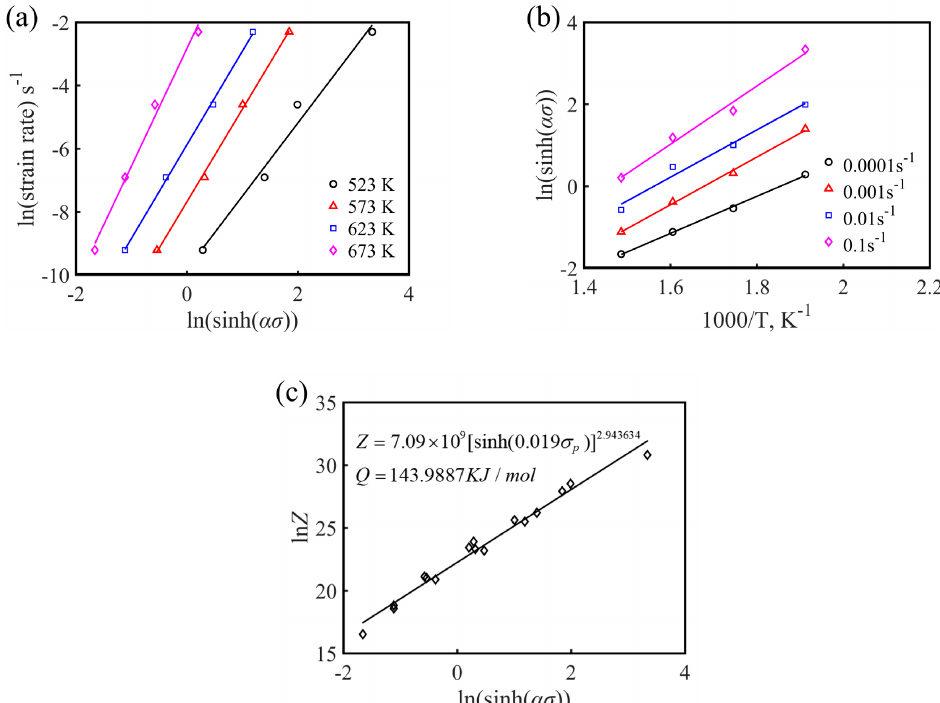
. ε . ε Figure 6. ( a ) ln -ln σ and ( b ) ln - σ linear regression curves for the experimental alloy.